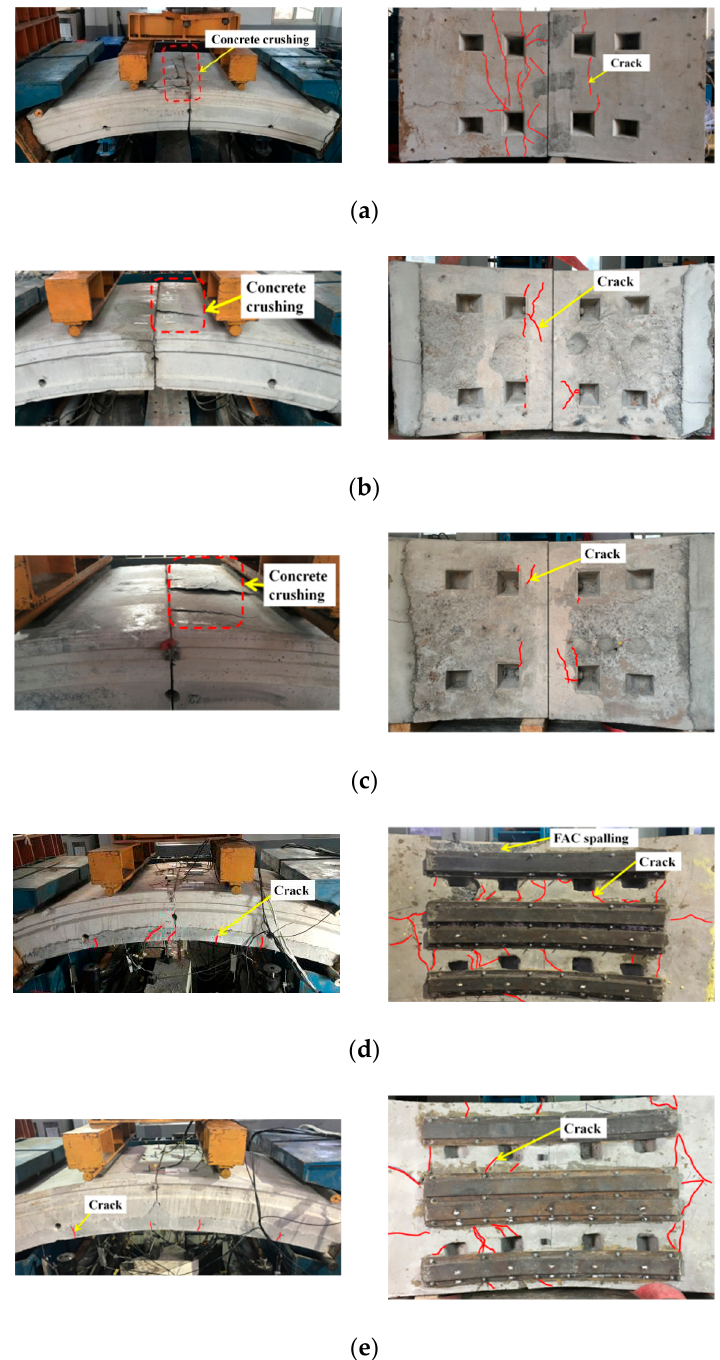
Figure 14. Concrete crushing and cracks. (a) Specimen S0; (b) specimen S60; (c) specimen S120; (d) specimen S60C; (e) specimen S120.